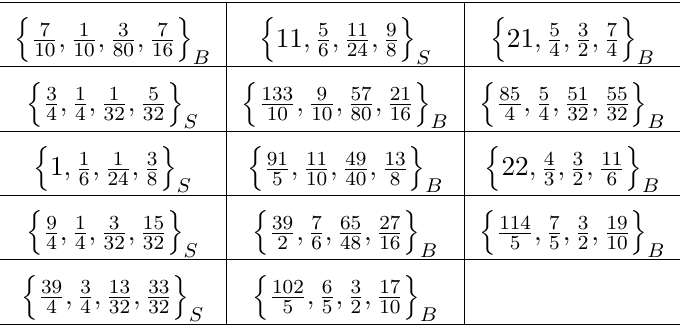
Table 3 . Rank 2 non-degenerate unitary theories with ‘ = 0 , which are all discovered in [35]. Type: S=SUSY, B=SUSY